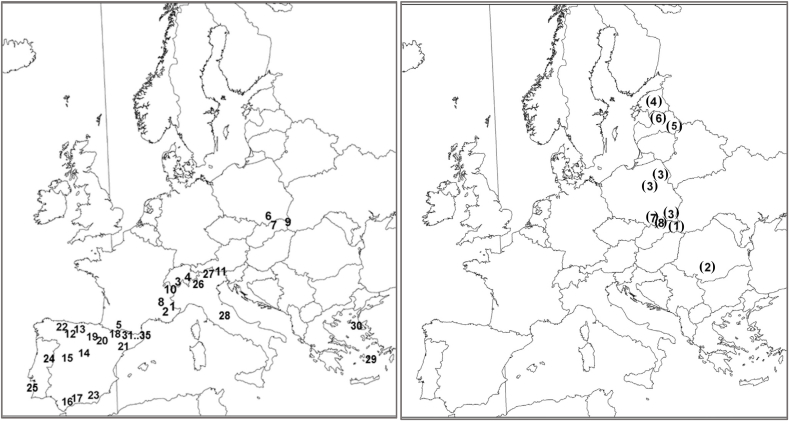
Distribution of the reported local shares of abandonment (hotspots) refers to the 35 study areas identified in Lasanta et al. (2016).